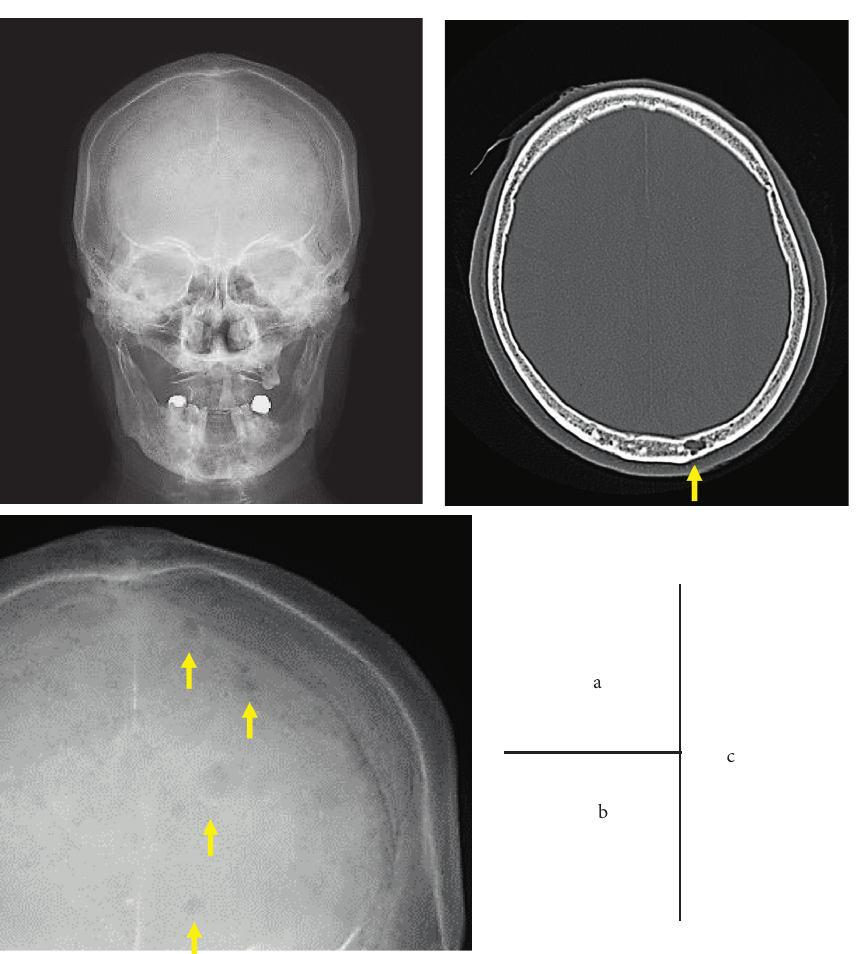
Figure 5: Osteolytic lesions of the skull. Head skeletal X-rays (a and b) and computed tomography (CT) (c) showed multiple, lytic, and punched-out lesions in the skull (arrows).